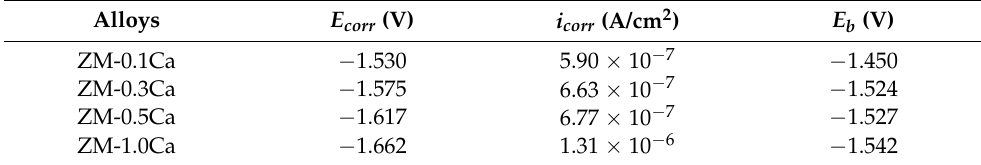
Figure 6. Corrosion rates of the ZM-xCa alloys obtained by weight loss after immersion in Hank’s solution for different times.